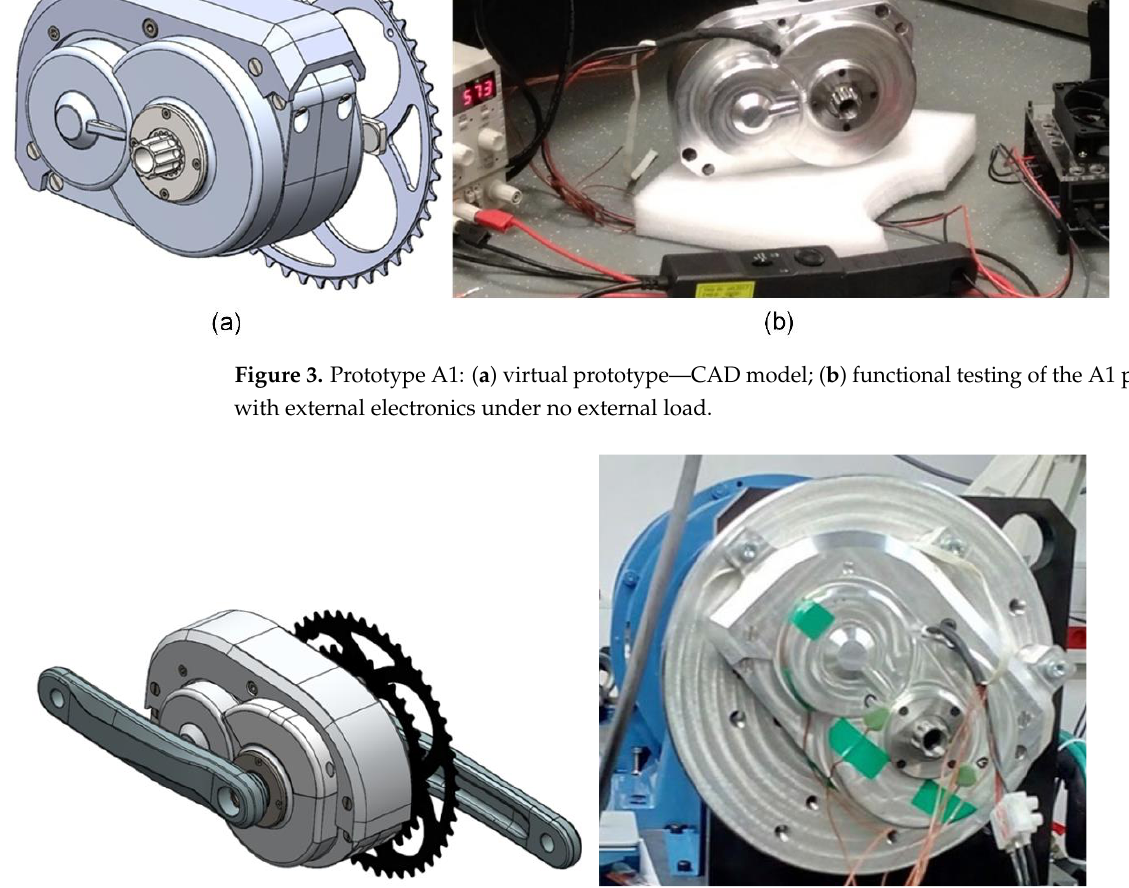
Figure 3. Prototype A1: ( a ) virtual prototype — CAD model; ( b ) functional testing of the A1 proto- type with external electronics under no external load.